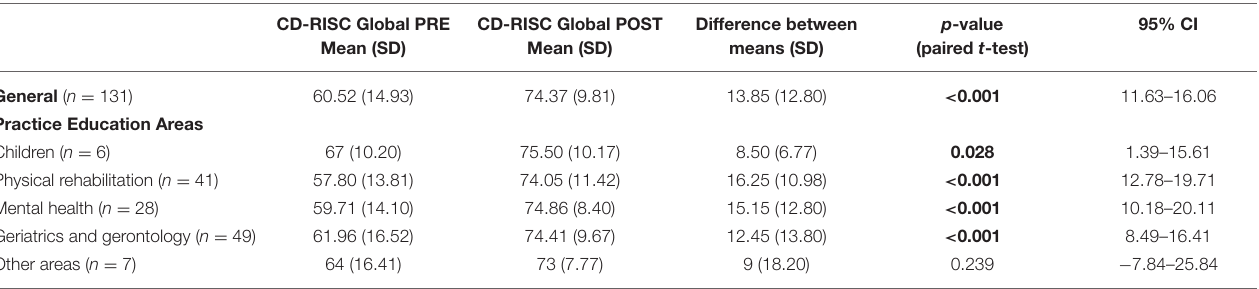
TABLE 3 | Practical training PRE-POST scores of global resilience (CD-RISC 25) in female students ( n = 131).